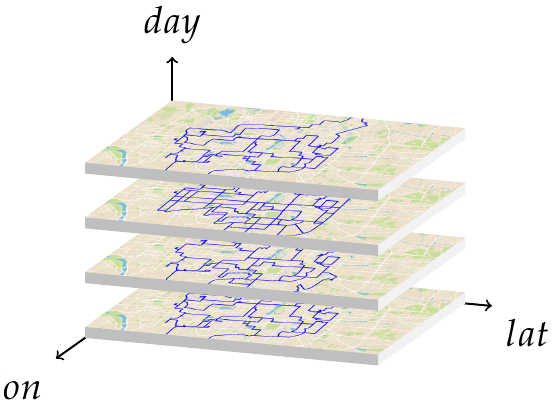
Figure 4. Hierarchical graph of trajectory based on time